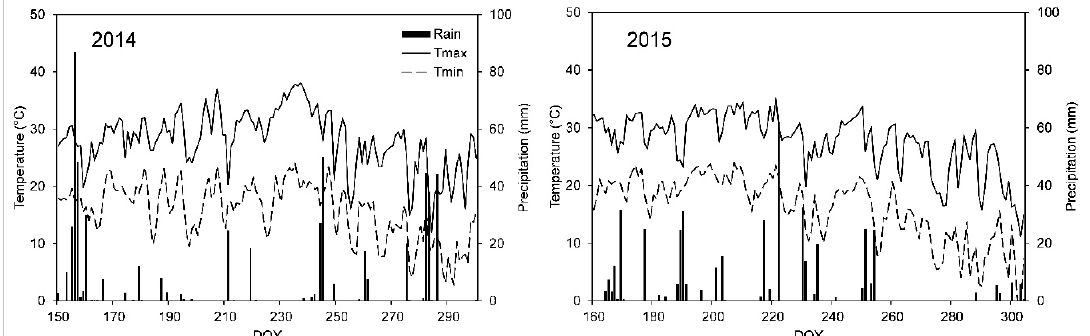
Figure 1. Overview of the vineyard: the experimental vine rows with different irrigation treatments and the individual vines grafted on the same rootstock in each plot are drawn on an image acquired with Sony’s Alpha ILCE-7R camera on September 21, 2015.